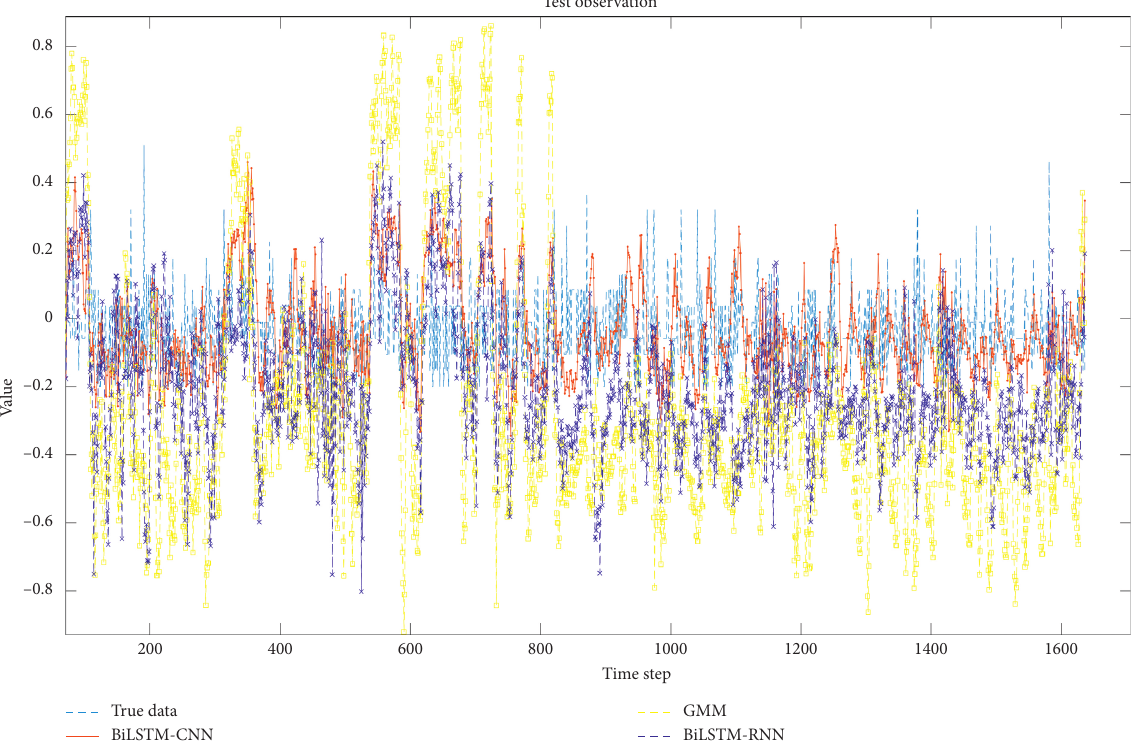
Figure 8: Kinematics comparison of F2 based on different network.